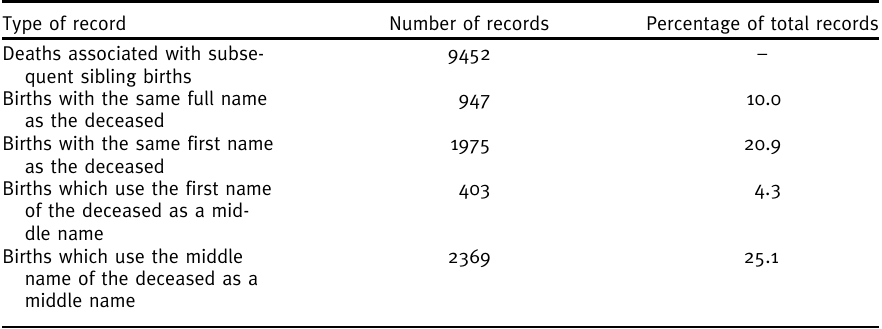
NUMBER OF DEATH RECORDS ASSOCIATED WITH SUBSEQUENT SIBLING BIRTHS, AND THE PROPORTION OF WHICH THAT RE-USE THE NAME, IN PART OR IN